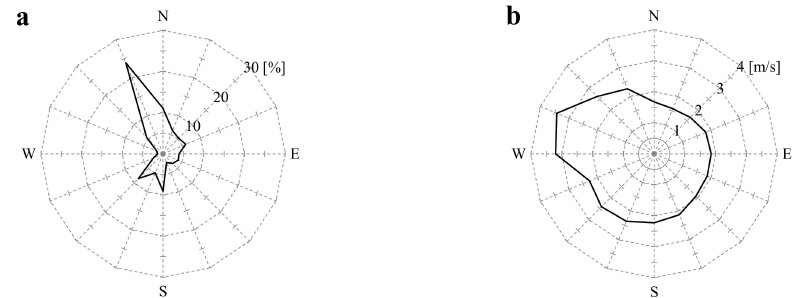
Figure 6. Wind rose for Tokyo: ( a ) the percentage of occurrences of wind directions, and ( b ) the mean velocity for each wind direction.